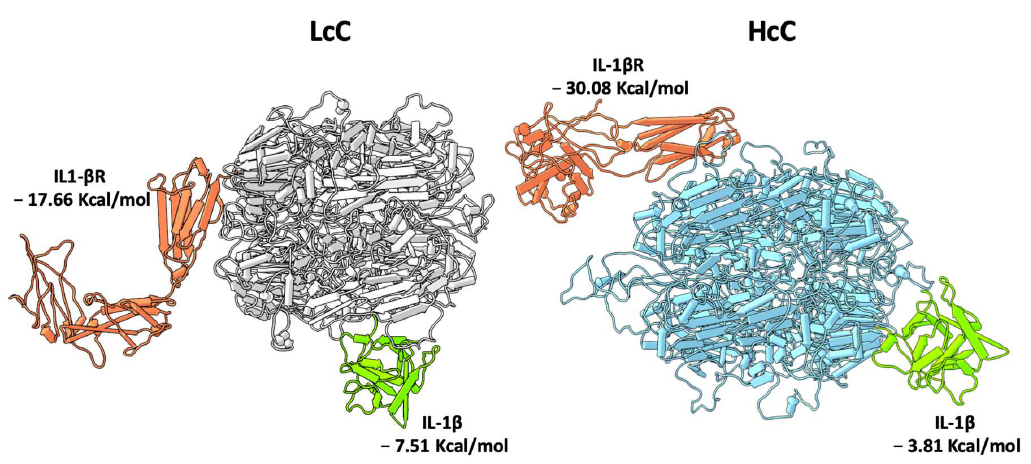
Figure 5. Molecular docking models. Pipes and plank representation of IL-1 β (green) and the soluble IL-1 β receptor (orange) binding to LcC (grey) and HcC (light blue). The binding energy for each complex is reported.